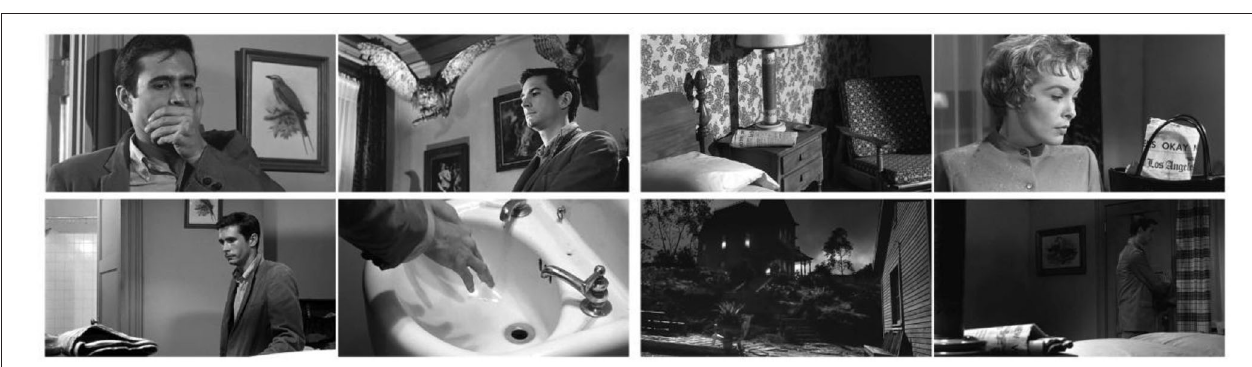
FIGURE 4 | The sample of video screenshots that were not shown during fMRI